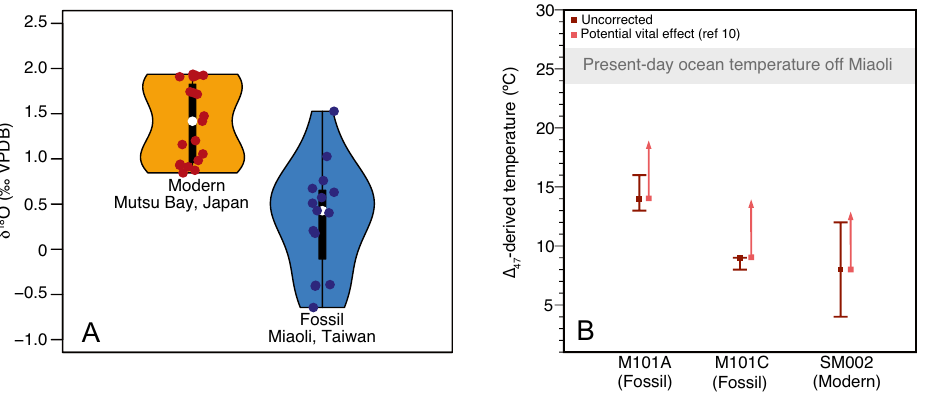
Figure 3. ( A ) Violin plots illustrating the distribution of stable oxygen isotopic compositions and ( B ) temperature estimates derived from clumped isotopes of both fossil and modern specimens of S. mirabilis . The error bars in panel B indicate the uncertainty of the ∆ 47 temperature for each sample, calculated from the standard error of the measurement (1 sigma, n = 3) and then propagated through the temperature calibration. Due to the non-linearity of ∆ 47 -temperature calibration and the fact that the error estimate is rounded up to the nearest whole number after being converted to temperature unit, the error bars may be asymmetric (e.g. M101A) or one of the error limits may overlap with the mean value (e.g. M101C). See Table S2 for ∆ 47 data and Methodology section for more detail on the calculation. The red arrows in panel B indicate potential vital effect (0.0146 ± 0.0042‰) as reported by Davies and John 10 , corresponding to ~ 4.5 °C of underestimation. The gray shaded bar indicates the present-day ocean temperature averaged over the upper 50 m water column off Miaoli based on the climatology data retrieved from the closest grid point in the World Ocean Atlas 2018 (Ref. 14 ) at 24.5° N 120.5° E and the Ocean Data Bank (http:// www. odb. ntu. edu. tw/) at 24.5° N 120.75° E (details in Supplementary Information).